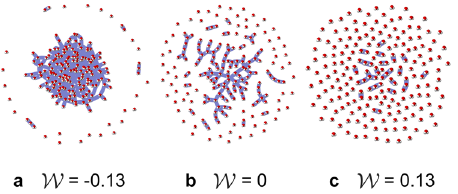
Fig. 2 | Topology of network model. Snapshots of the hidden-variable model topologyat a W = (cid:2) 0 : 13, b 0,and c 0.13inanetworkof N =200.As thevalueof W increases, the networkexhibits thesystem-spanning clusterof the liquid-likestate, the scale-free cluster size distribution along the Widom line, and the low-density mode of the vapor-like state, respectively. The conditions visualized here corre- spond (through Equation (10)) to the thermodynamic state points shown in Fig. 1. For visualization purposes, each node is represented with an image of a water molecule. Clusters are depicted by pale blue shading.